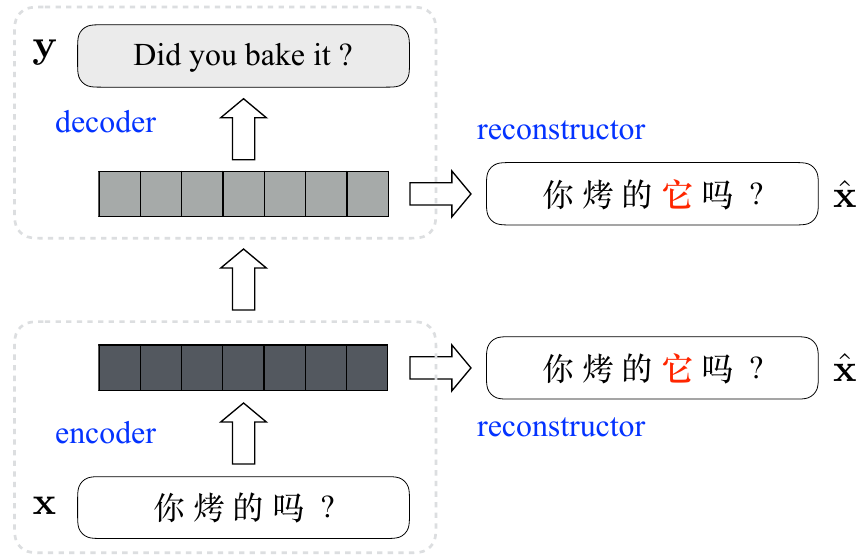
Figure 6. The architecture of reconstructor-augmented NMT. The Chinese word in red is a zero pronoun it